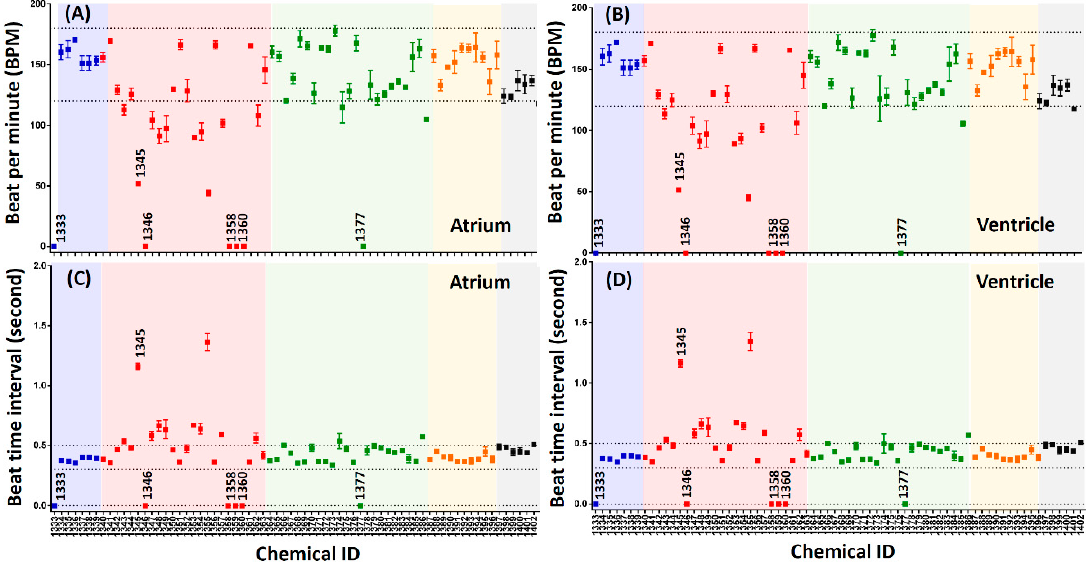
Figure 2. The end-point screen result for ion channel ligand library by using zebrafish embryos aged 72 hpf. ( A ) Atrium and ( B ) Ventricle beat per minute (BPM) for each compound screened. ( C ) Atrium and ( D ) Ventricle beat time interval (rhythmicity) for each compound screened. The color code is blue for intracellular calcium channels, red for calcium channels, green for potassium channels, yellow for sodium channels, and grey for miscellaneous channels. The numbers above some points shows the candidate compounds which were shown to induce irregular heart rhythmicity by using end point screening method. They are compound 1333 (Antibiotic A-23187), 1345 (Flunarizine hydrochloride), 1346 (FPL-64176), 1358 (Niguldipine-HCl), 1360 (Pimozide) and 1377 (Fluspirilene), respectively.